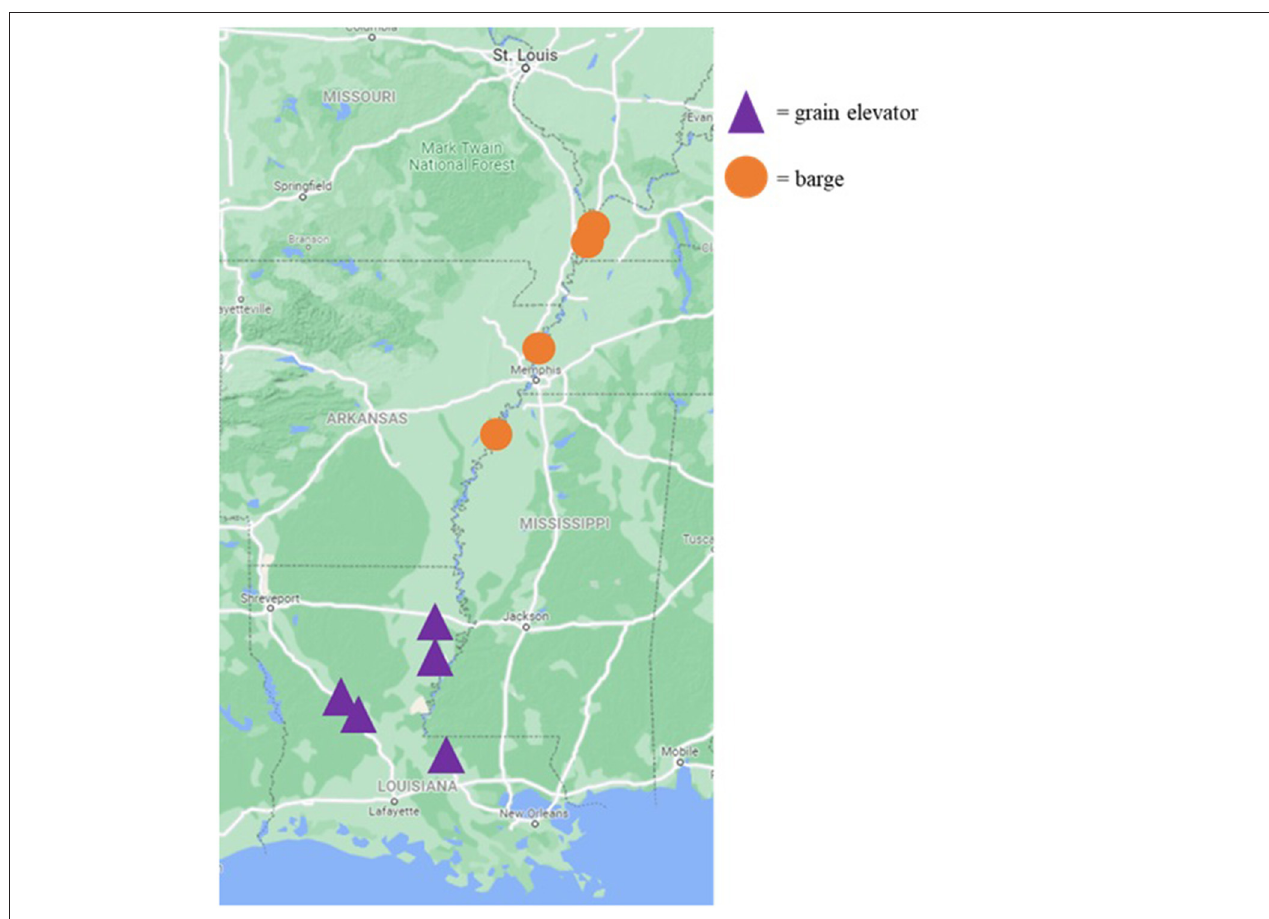
FIGURE 1 | Map of approximate locations of where grain elevator (purple triangles) and Mississippi River Valley barge (orange circles) samples were collected